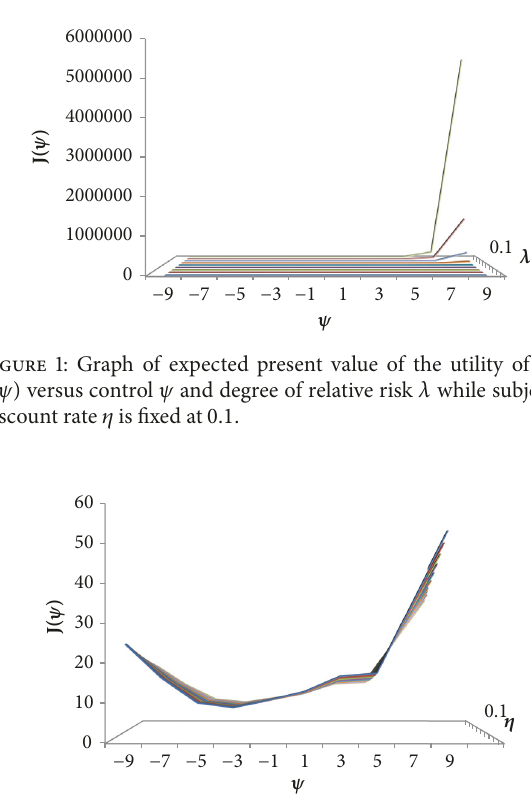
Figure 2: Graph of expected net value of the utility of asset 𝐽(𝜓) versus control 𝜓 and subjective discount rate 𝜂 while degree of relative risk 𝜆 is fixed at 0.1